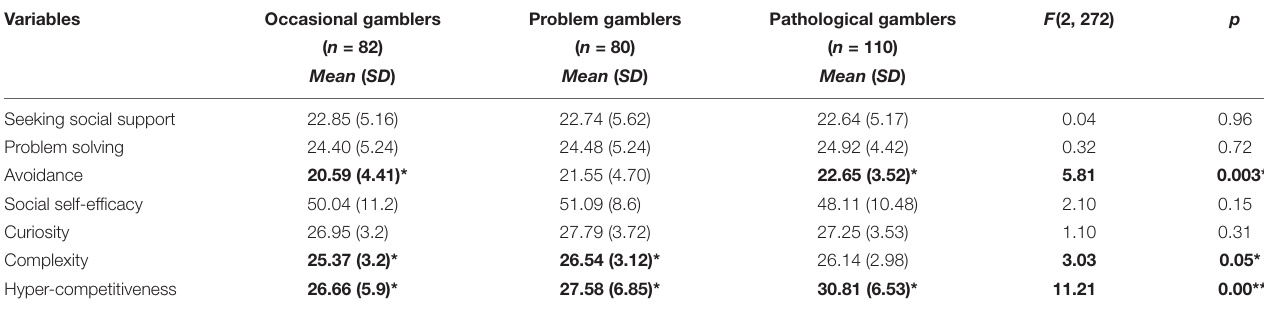
TABLE 1 | Descriptive statistics on different groups of PGs.